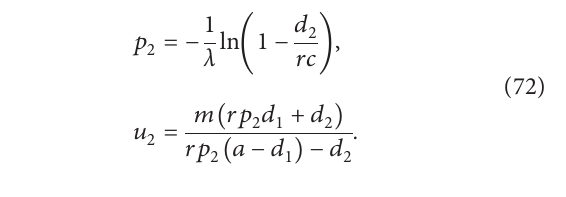
� 0 . 3, d � 0 . 2 and d � 0 . 0 1 2